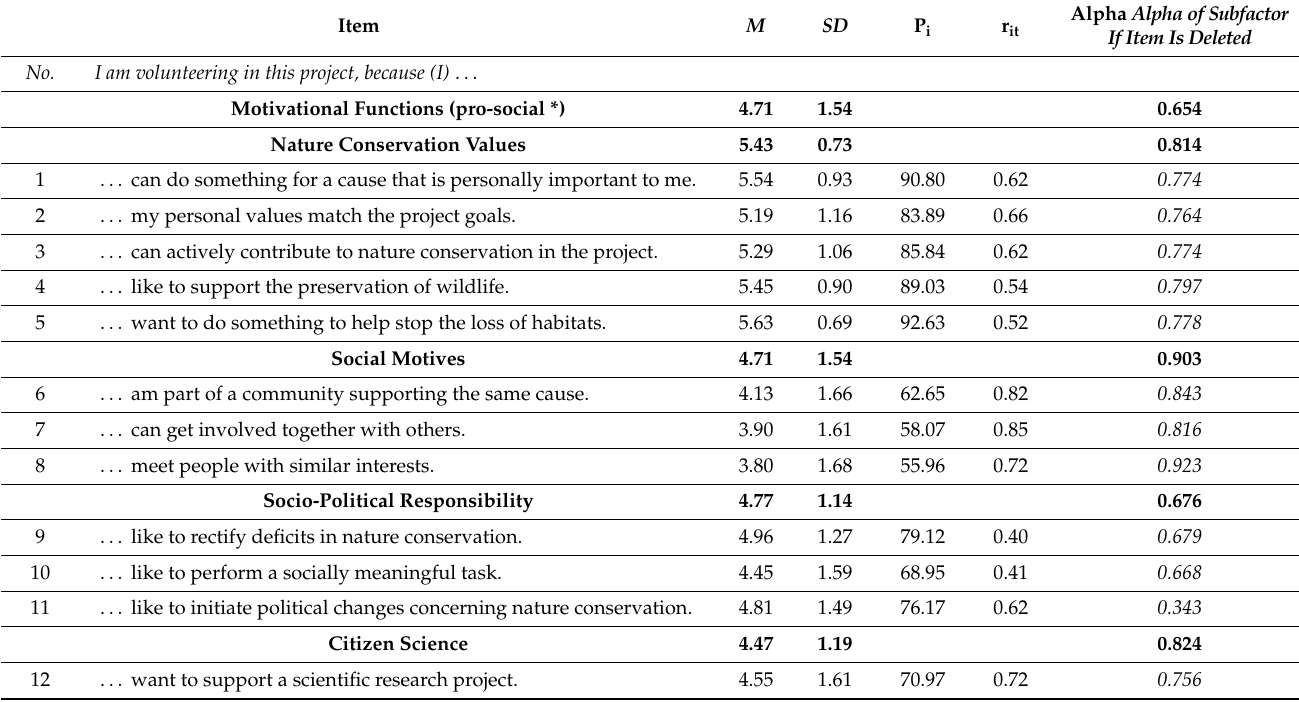
Table 2. Items and item analysis of Motivational and ORganisational Functions of voluntary ENgagement in Citizen Science (MORFEN-CS) 1 . Item M SD P i r it